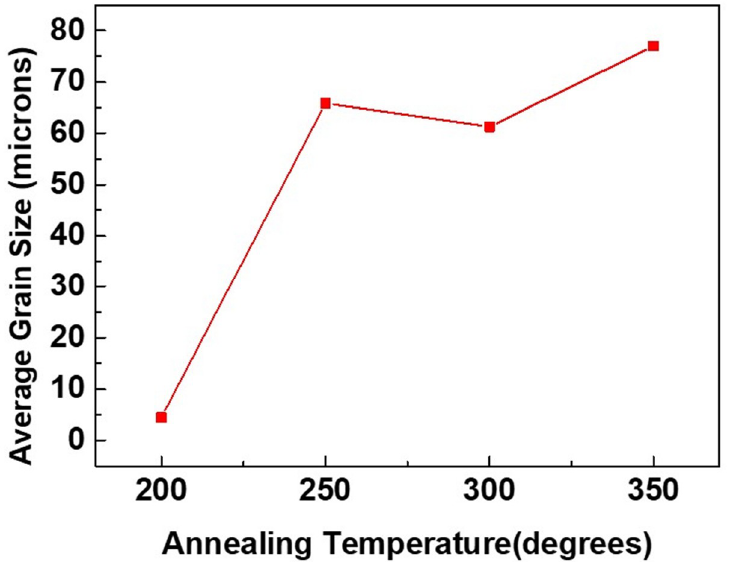
Figure 8. Average grain size variation under various annealing conditions.